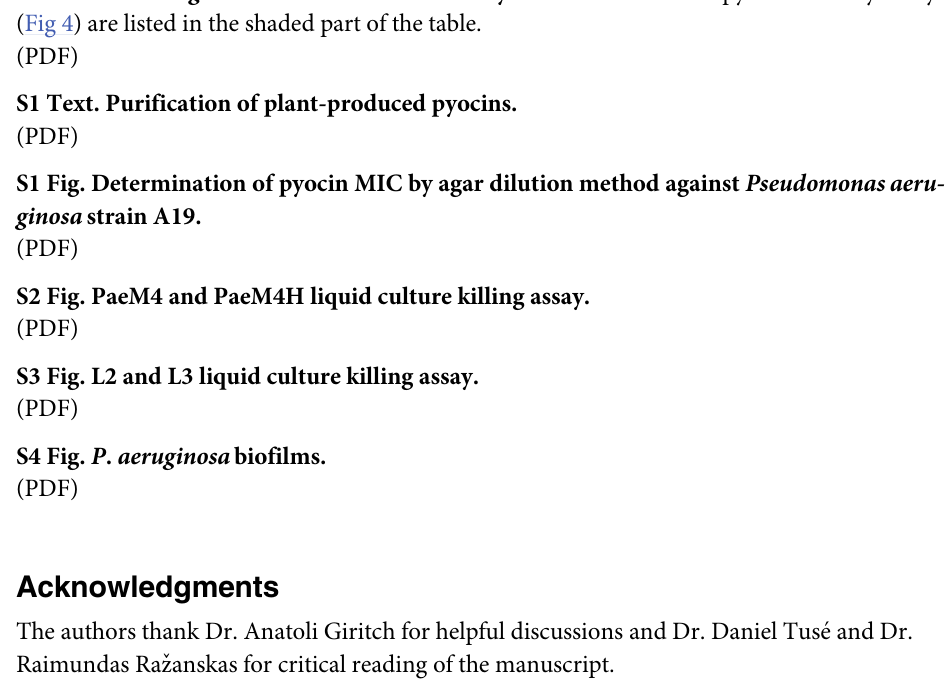
S1 Fig. Determination of pyocin MIC by agar dilution method against Pseudomonas aeru- ginosa strain